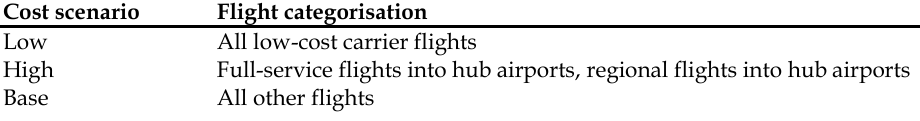
Table 1. Cost scenarios assigned to